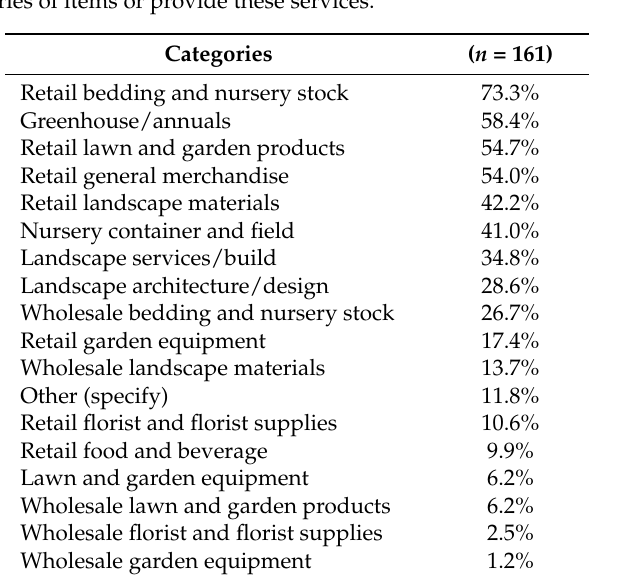
Table 3. The percentage of ornamental horticulture industry respondents that indicated they carry these general categories of items or provide these